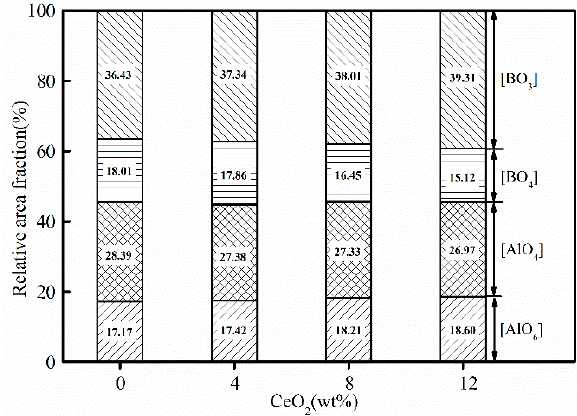
Figure 8. The relative area fraction in the experimental mold fluxes.